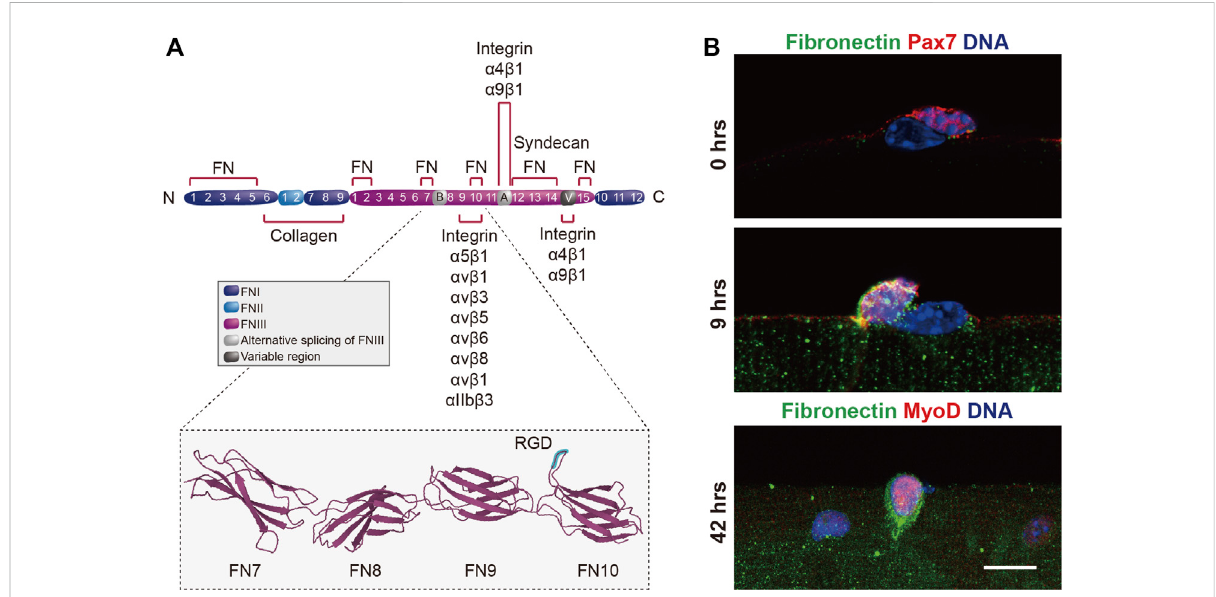
Autologous expression of fi bronectin by MuSCs. (A) Scheme showing the domain structure of fi bronectin and the binding sites for collagen, integrin and syndecan. The insert shows the seventh through the RGD-containing 10th type III repeats of fi bronectin (Leahy et al., 1996) obtained from the RCSB Protein Data Bank (Berman et al., 2000). The RGD motif is highlighted in blue. (B) Immunostaining showing the endogenous expression of fi bronectin (green), Pax7 orMyoD (red) and DNA (blue) in muscle stem cells on enzymatically isolated mouse single muscle fi bers after 0, 9, and 42 h (hrs) in culture. Scale bar = 20